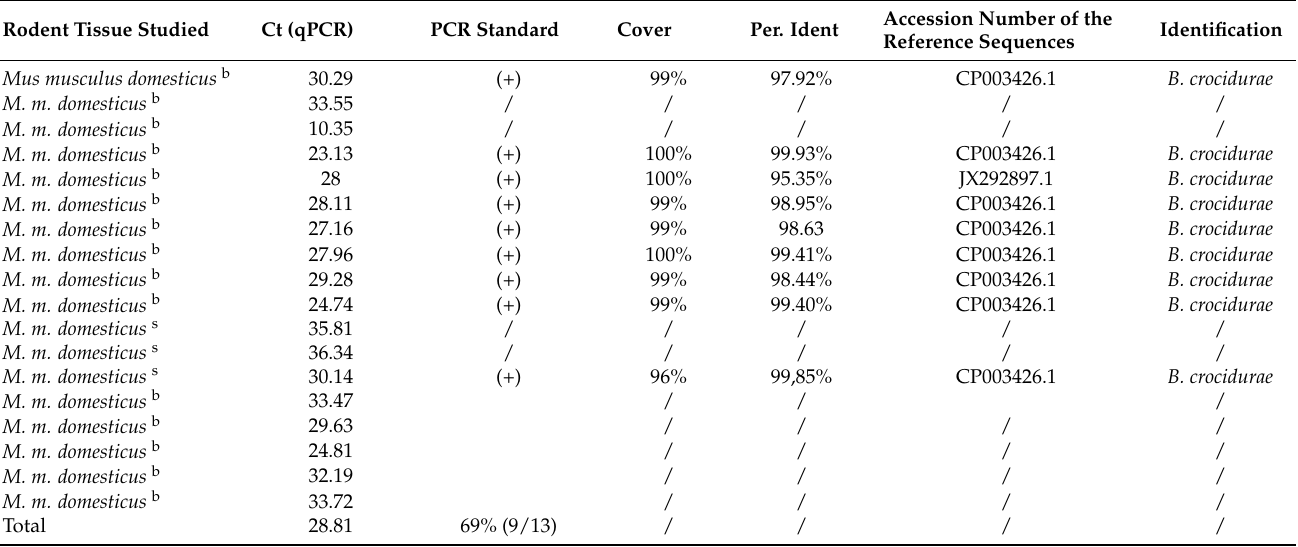
Table 3. Results of Borrelia spp. detection in brain and spleen tissue from rodents caught in Dodel using qPCR and standard PCR.